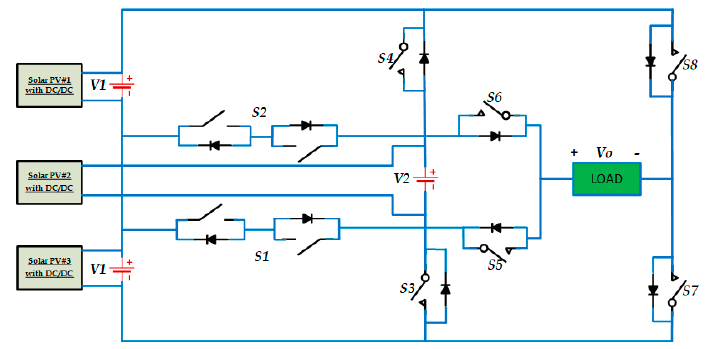
Figure 11. 13 − Level MLI.